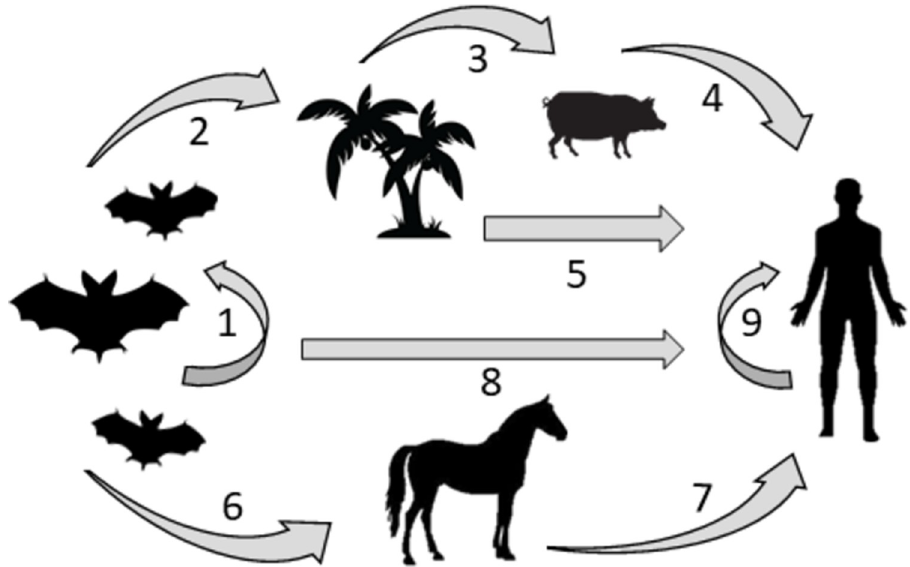
Fig 2. Schematic representation of pathogenic Henipavirus transmission from the natural host, fruit bats, to susceptible species. Shown are supposed transmission routes: (1) from bats to bats via placental transmission, lactation, or matting; (2) fruit consumption; (3) excretion and partially eaten fruits; (4) from pig to farmer (NiV Malaysia); (5) date palm consumption (NiV Bangladesh); (6) excretion; (7) from horse to owner (HeV Australia, NiV Philippines); (8) bite, scratch, etc.; and (9) from human to human (NiV Philippines, NiV Bangladesh).